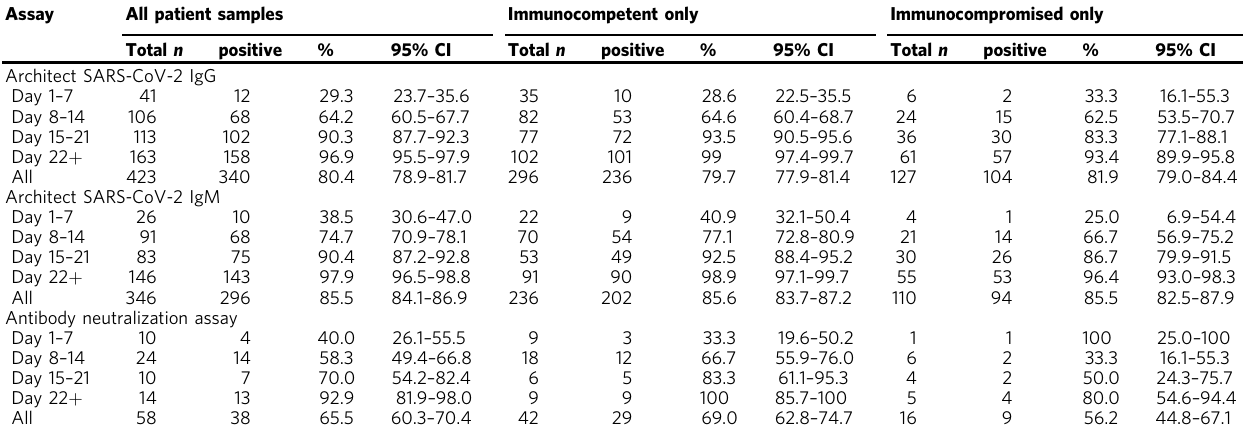
Table 1 Clinical sensitivities of the Abbott Architect SARS-CoV-2 IgG and IgM and in vitro neutralization assays. Percentage of positive specimens from patients with positive SARS-CoV2 RT-PCR grouped by days since symptom onset and immune